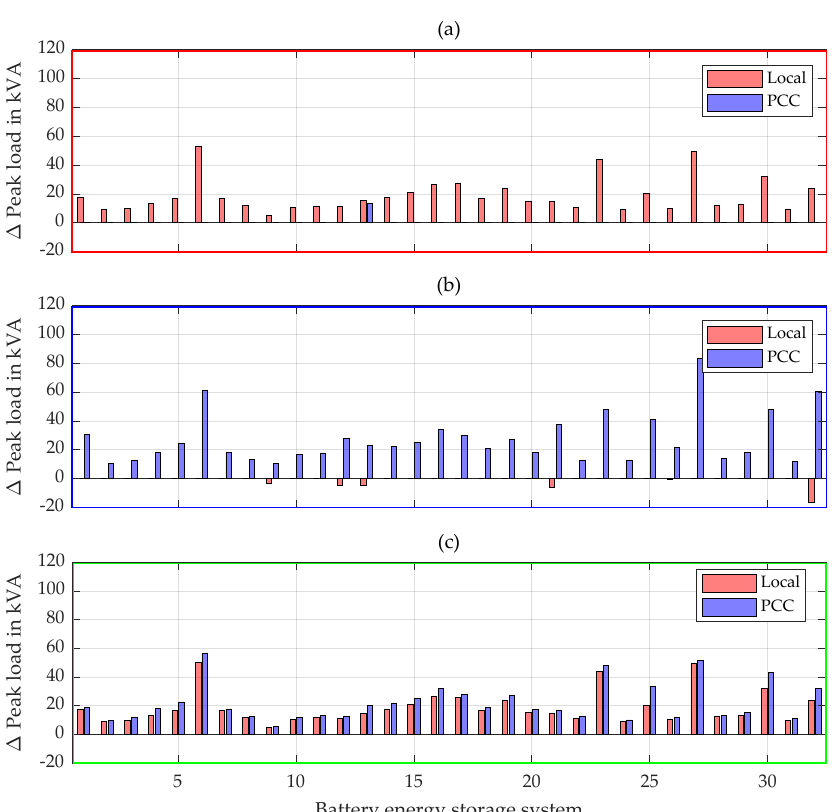
Figure 7. The upper plot ( a ) shows the absolute peak load reduction for each simulation if the battery energy storage system (BESS) is operated with strategy α . Plot ( b ) shows the results for the centralized approach (Strategy β ). The lower plot ( c ) shows the absolute peak load reduction for each simulation if the BESS is operated with the newly developed combined approach (Strategy γ ). The red bars show the difference in peak load at a local node b, the blue bars show the peak load reduction at the point of common coupling